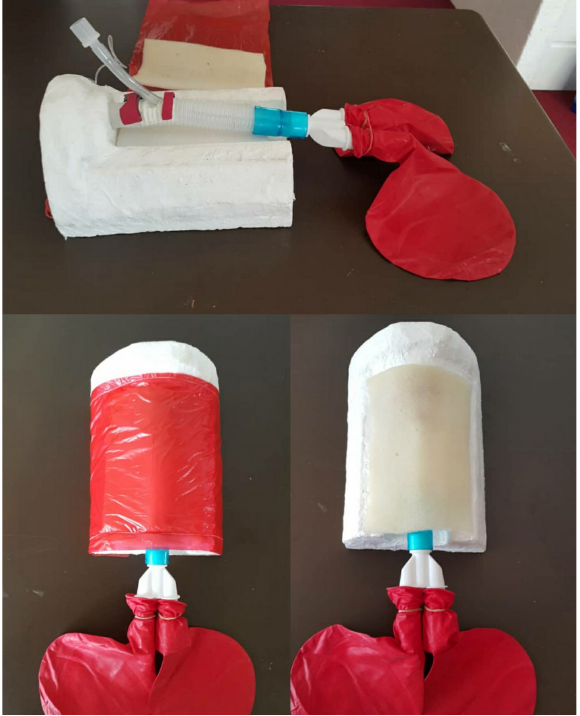
Figure 1. Teacher-made cricothyrotomy